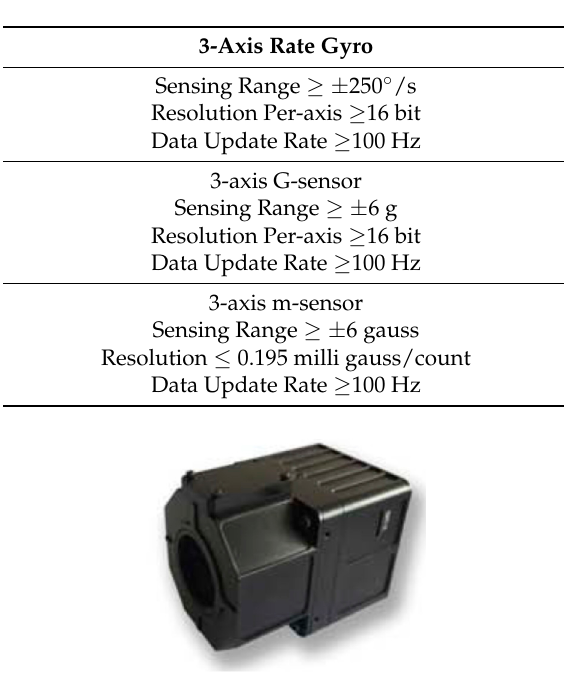
Table 1. Specifications of the IMU. (Source: AI-RIDER Corp.).